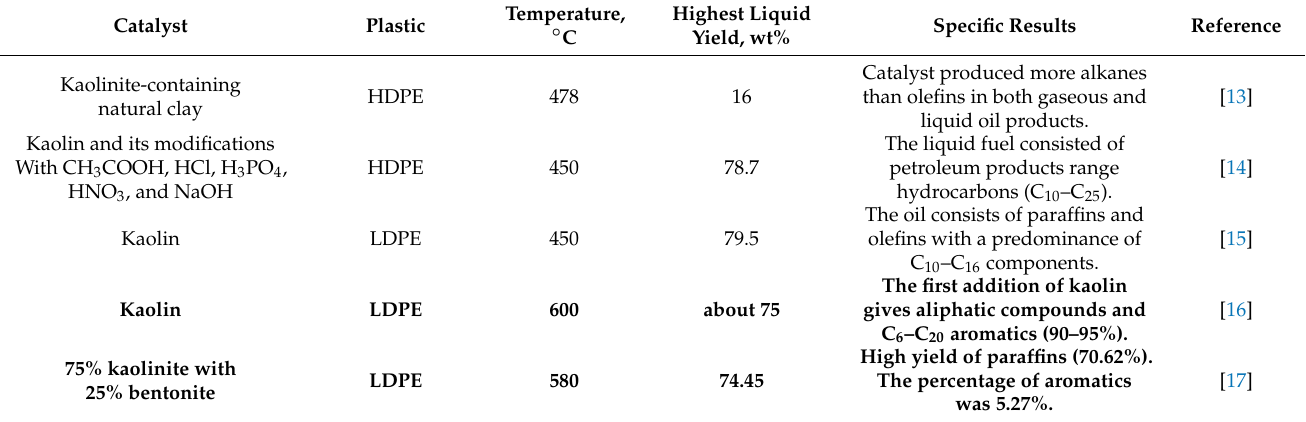
Table 1. Publications on the conversion of different plastics over clay minerals from kaolin group catalysts.